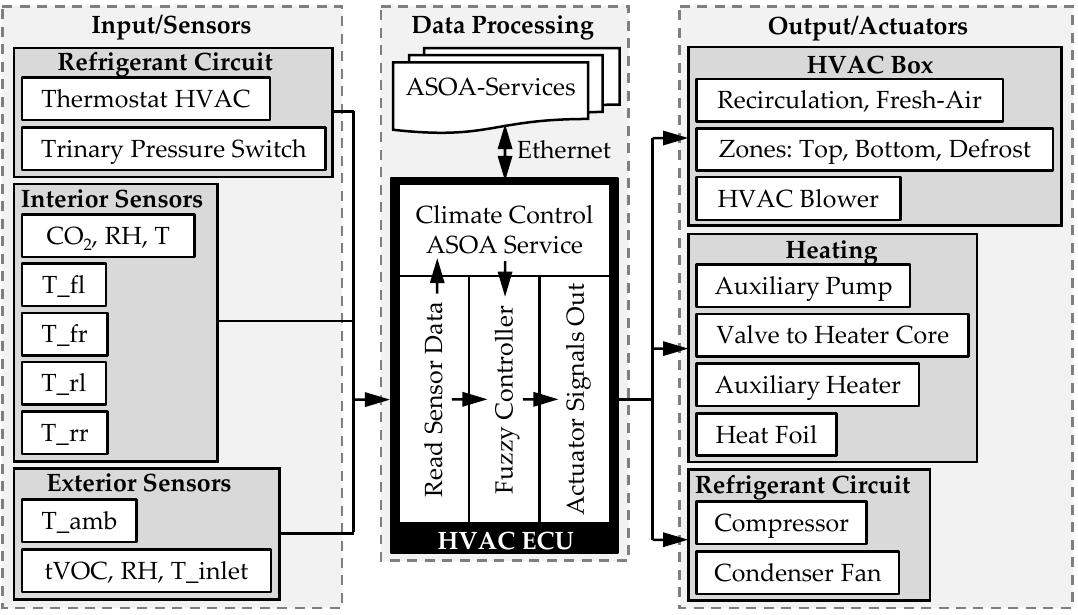
Figure 4. Input-output model of the HVAC-System ECU.